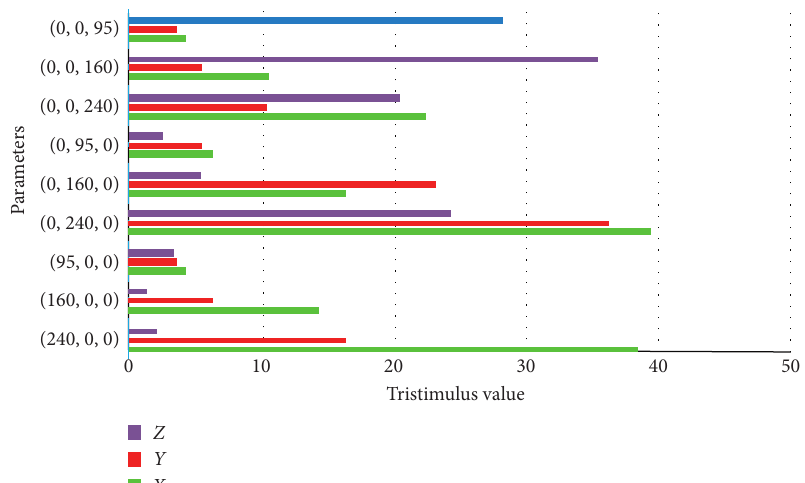
Figure 4: HSI- XYZ measured value with RGB single-channel drive.